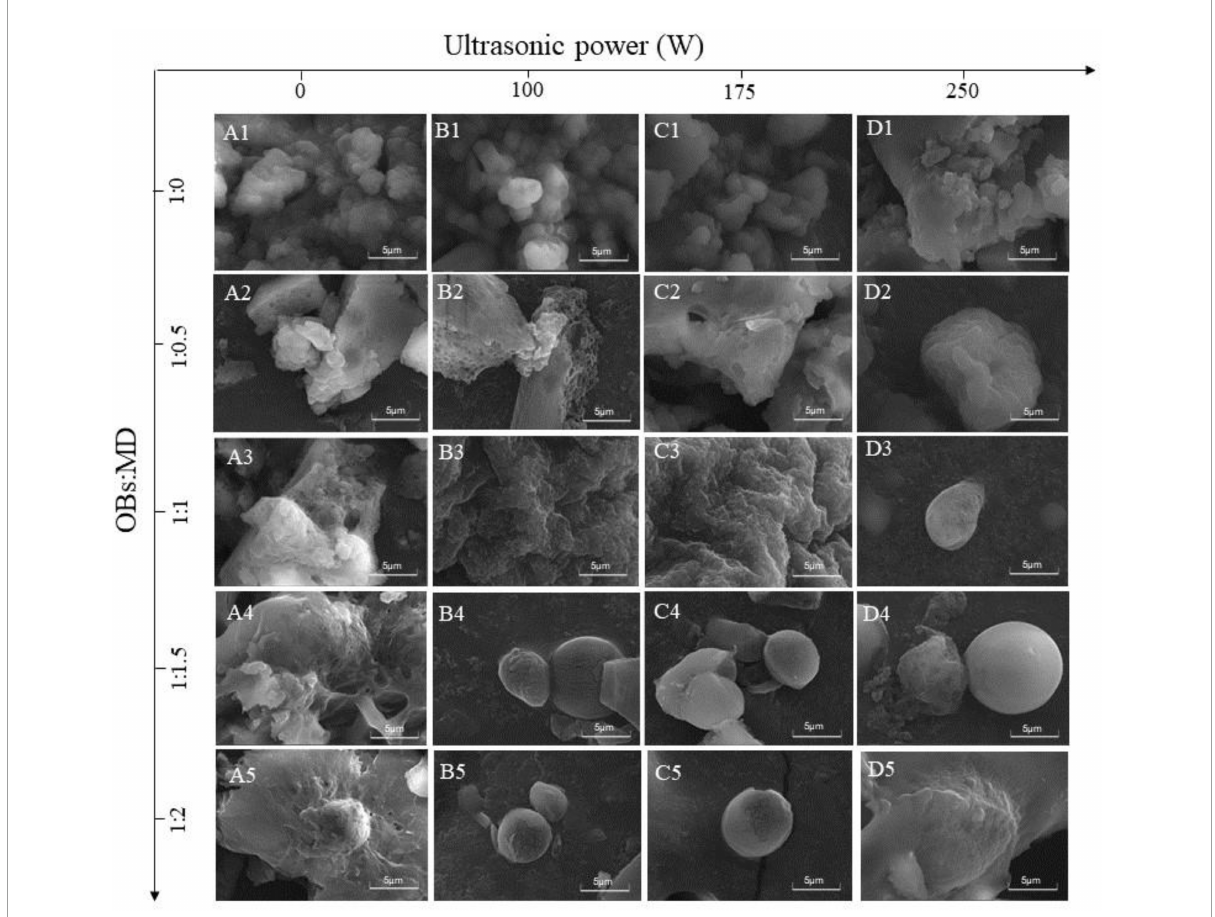
FIGURE7 SEM images of OBs, OB-MD 0.5, OB-MD 1, OB-MD 1.5, and OB-MD 2 after different ultrasound power treatments. (A1–A5) No ultrasound, (B1–B5) 100 W ultrasound, (C1–C5) 175 W ultrasound, and (D1–D5) 250 W